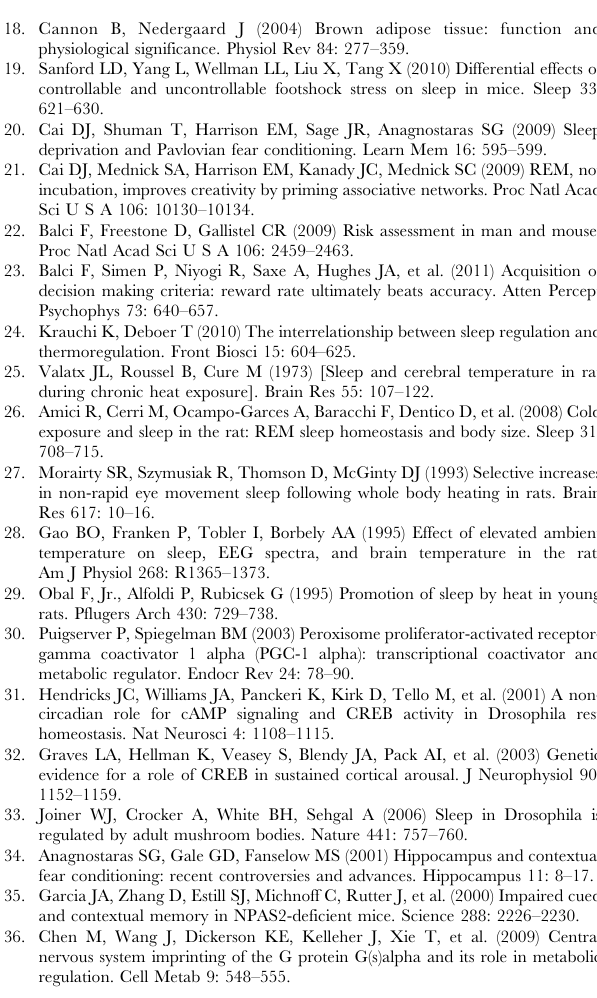
REM (blue lines) epochs are reported for all experimental conditions. Figure S2 Four-hour bins percentage and shadowed 6 s.e.m of REM (lower panel) sleep during 6-hour sleep deprivation (SD) and the following 6-hour recovery period. Grand-averages and shadowed 6 s.e.m. of body temperature (upper panel) are plotted for the same